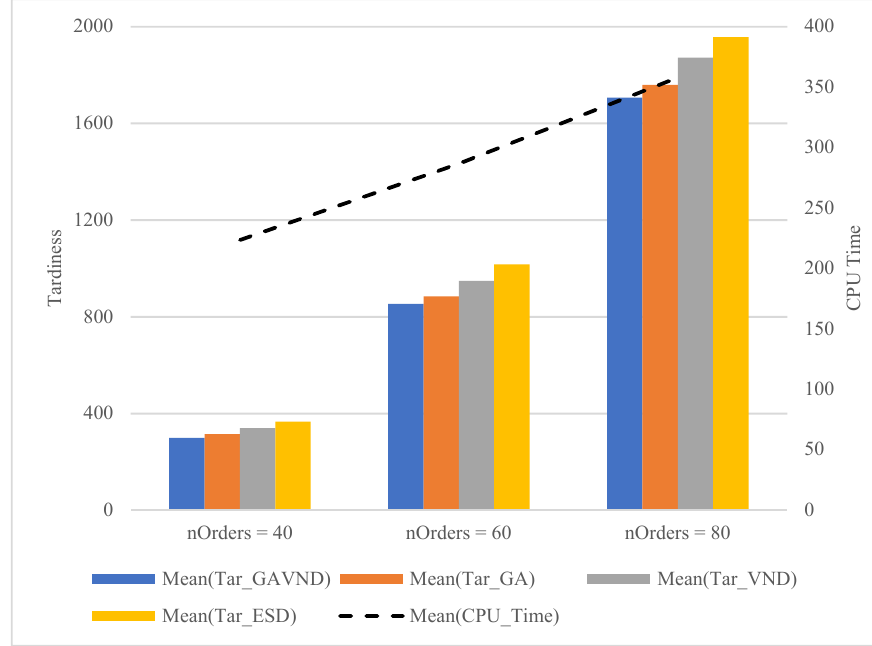
Figure 5. Effect of order sizes.